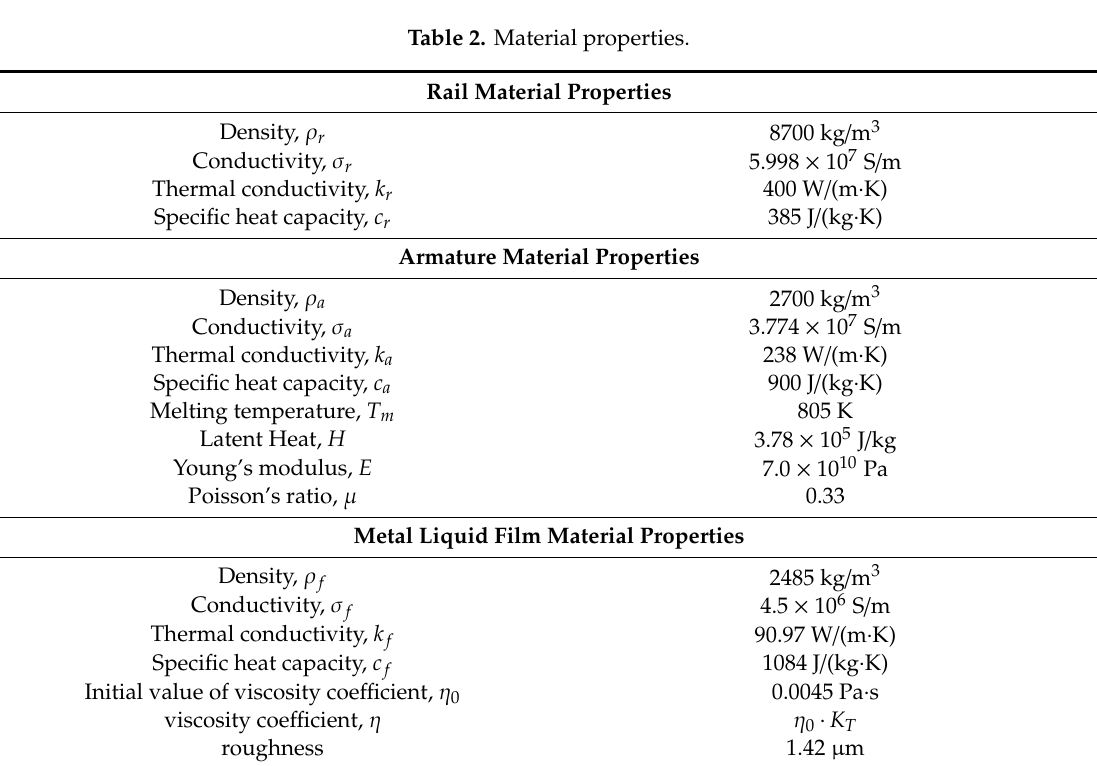
Table 2. Material